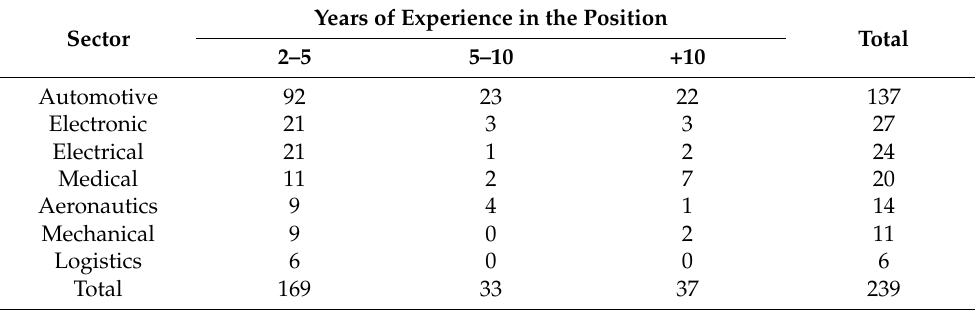
Table 2. Surveyed industrial sectors vs. employee work